Question: What direction does the quantity move in — increasing or decreasing?
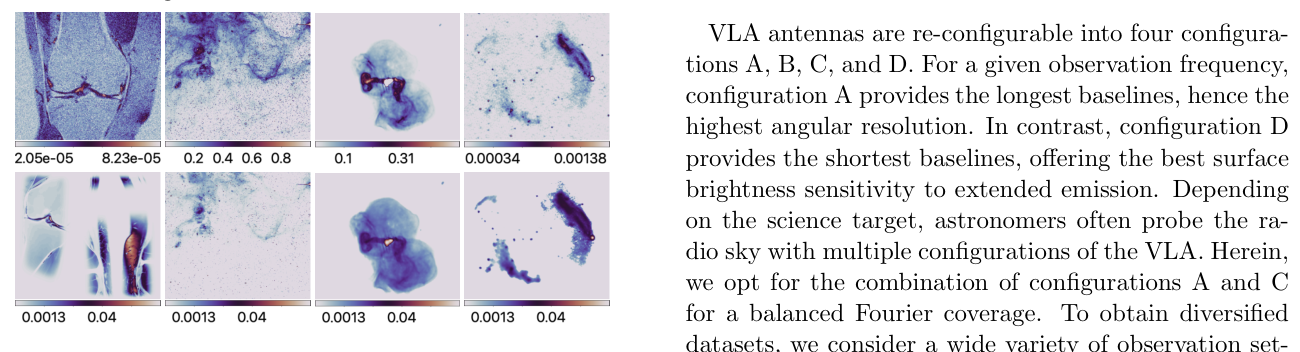
Answer: increasing